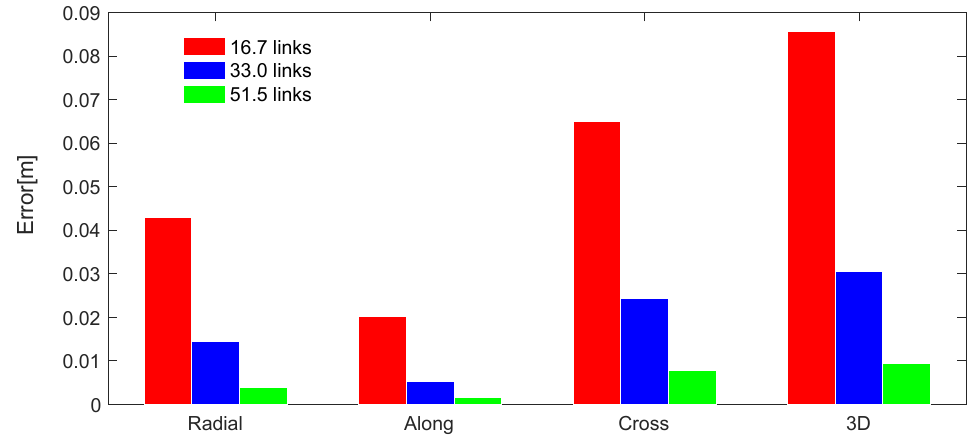
Figure 9. 192-LEO constellation orbital errors in radial, along-track, cross-track and 3D under 20 cm ranging accuracy, in which satellite of PRN 1, 10, 19, ... , 190 (divided at interval 9 of PRN number) are displayed.